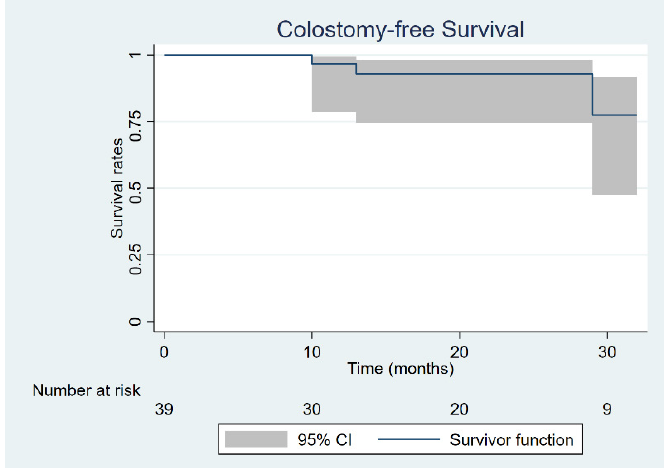
Figure 3. Colostomy-free survival.